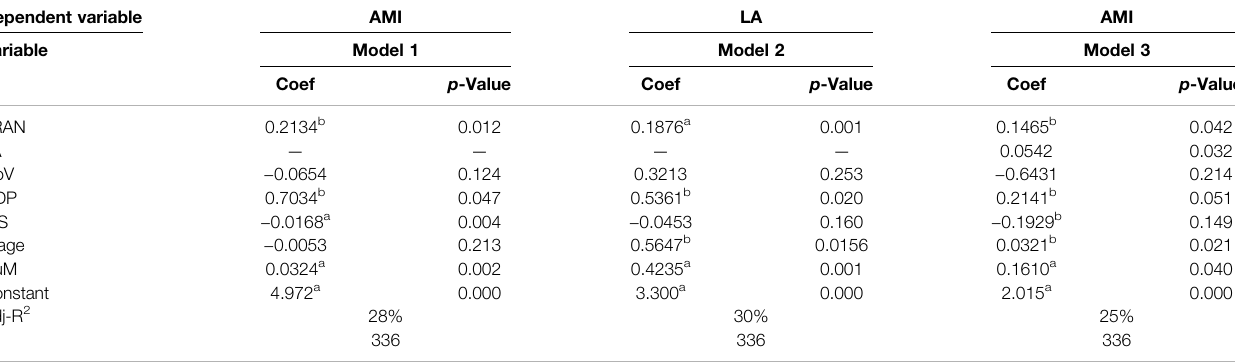
TABLE 1 | The relationship between urban rail transit on industrial agglomeration: mediating effect of labour agglomeration. Dependent variable